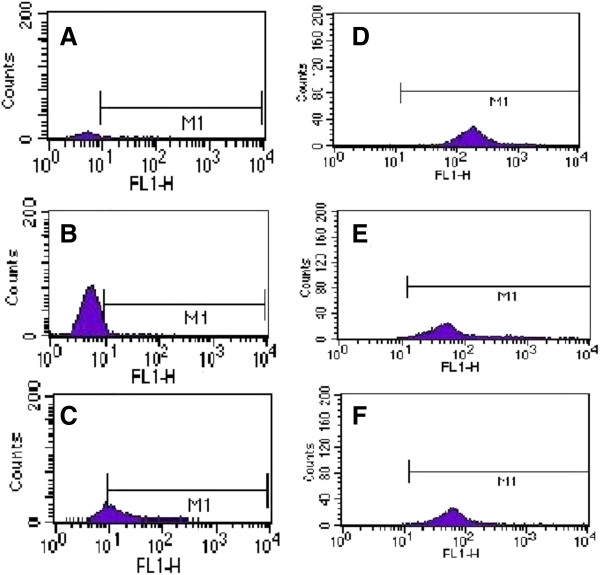
Phenotype of Bovine Monocyte-Derived Dendritic Cell (Mo-DC). The Mo-DC at seven days of differentiation were stained for CD14, CD21, CD205, MHCI, MHCII or CD86. The experiments were repeated three times and mean expressions were calculated. A) Cells showing mean CD14 expression as 1.025 ± 0.45%; B) Cells showing mean CD21 expression as 3.42 ± 0.19%; C) Cells showing mean CD205 expression as 55.97 ± 45.48%; D) Cells showing mean MHCI expression as 98.58 ± 0.34%; E) Cells showing mean MHCII expression as 94.1 ± 2.81%; and F) Cells showing mean CD86 expression as 77.83 ± 17.83%.